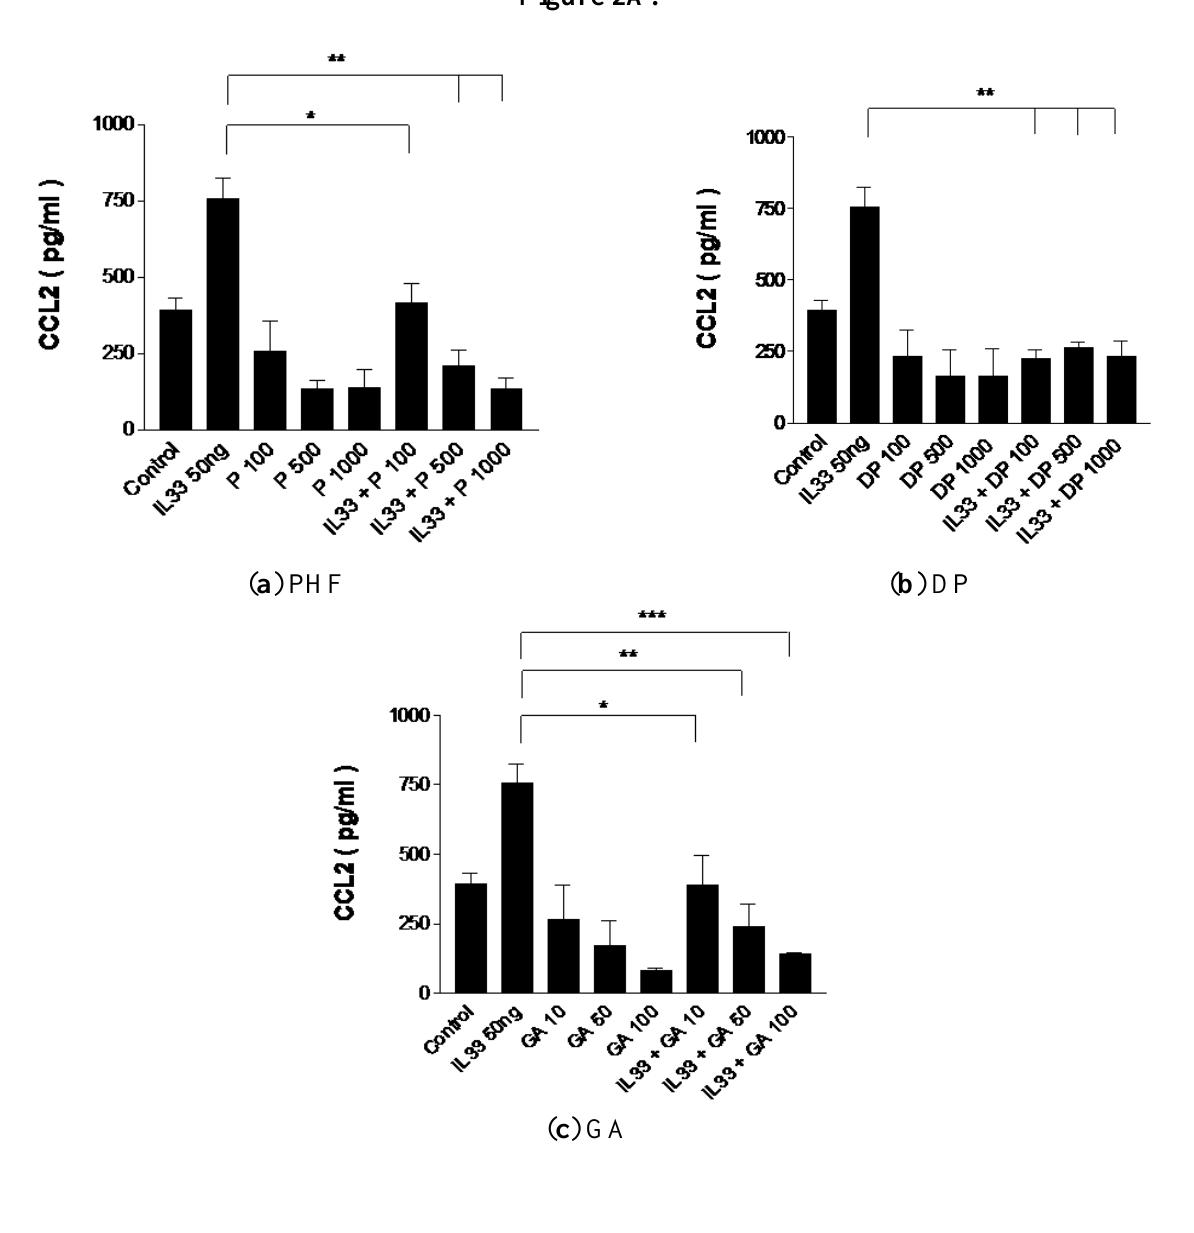
Figure 2. Suppressive effect on ( A ) CCL2, ( B ) CCL5 and ( C ) CXCL8 release from IL-33- activated human basophilic KU812 cells treated with PHF (100, 500 and 1,000 μg/mL), DP (100, 500 and 1,000 μg/mL) or GA (10, 50 and 100 μg/mL) for 18 h. Release of chemokines in culture supernatants was determined by CBA. * p < 0.05, ** p < 0.005, *** p < 0.001. P100-1000: PHF 100–1,000 μg/mL, DP100-1000: Danpi 100–1,000 μg/mL,